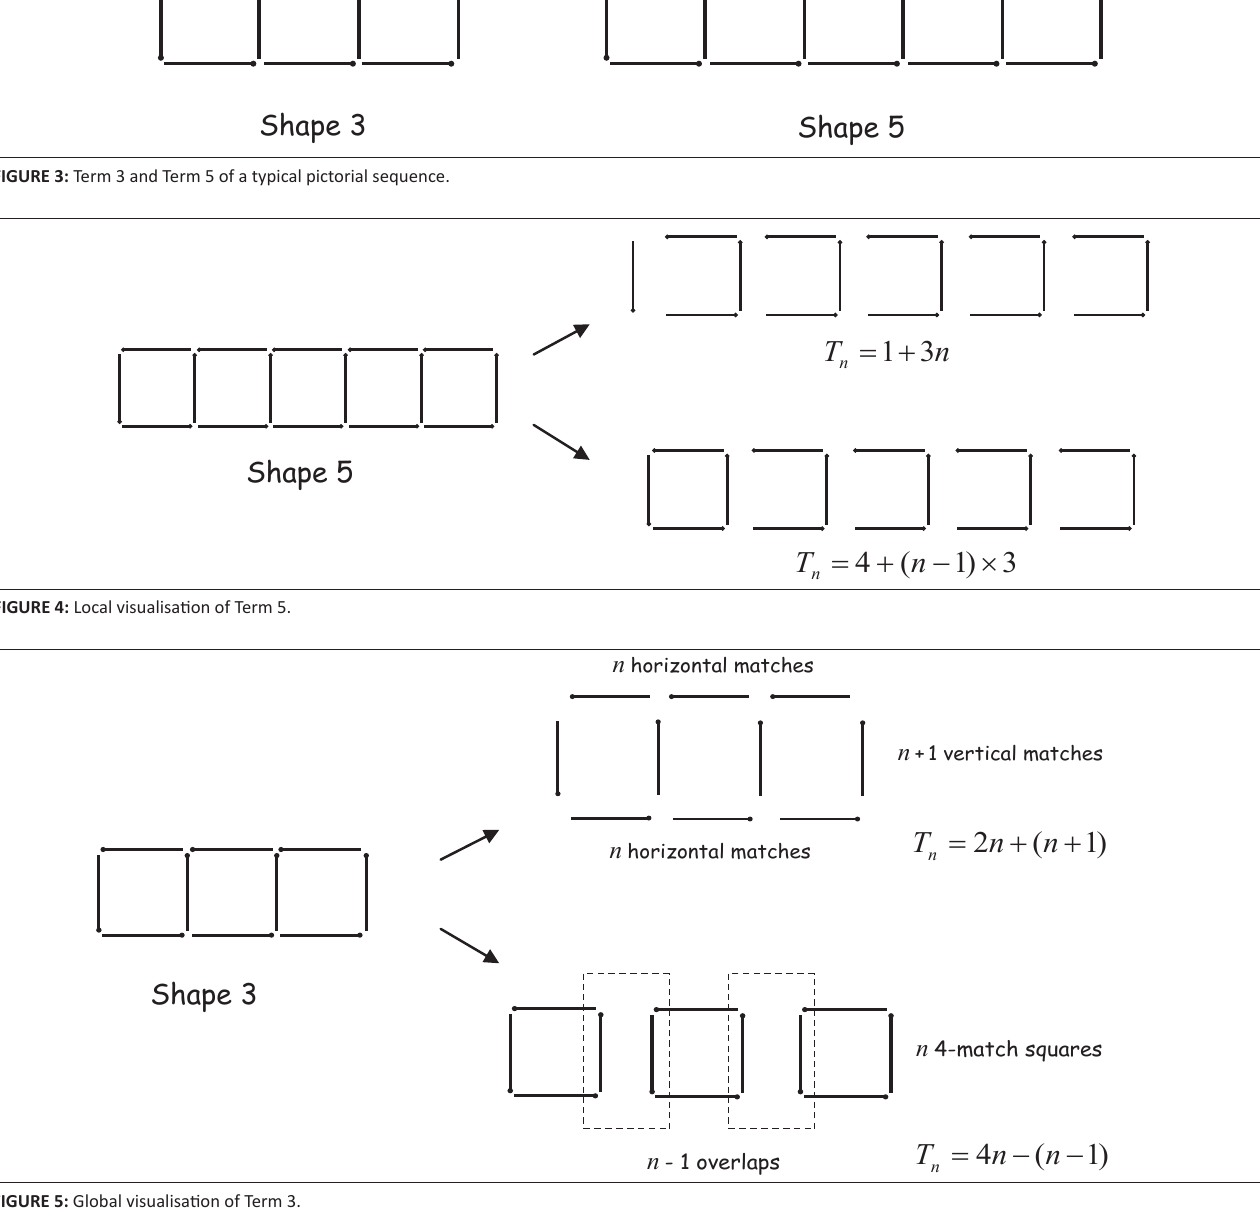
FIGURE 4: Local visualisation of Term 5. FIGURE 5: Global visualisation of Term 3.